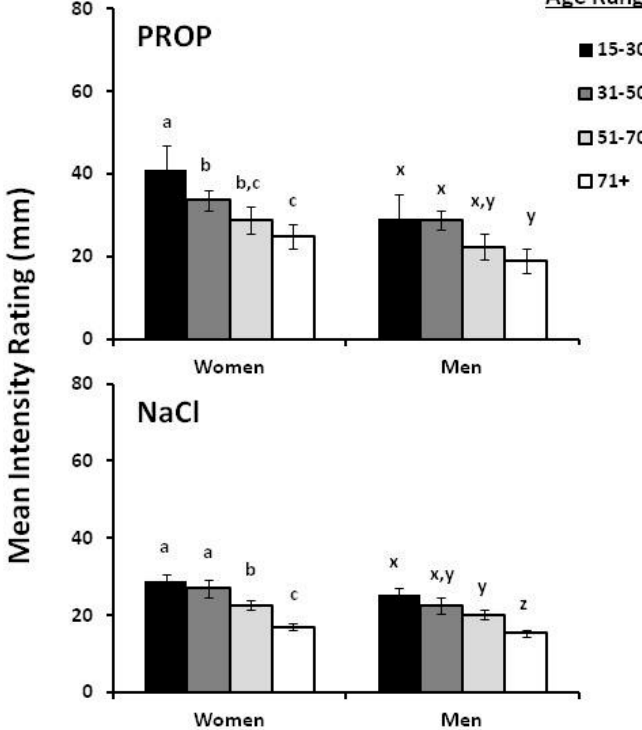
Figure 1. Mean (±Standard Error, SE) 6- n -propylthiouracil (PROP) ( top ) and NaCl ( bottom ) ratings across age groups in both women and men from the isolated community of Val Borbera, Northwest Italy. n = 589; sample size per age group: 59 (15–30 years); 191 (31–50 years); 261 (51–70 years); 78 (71+ years). Ratings by men and women were analyzed separately. For women, mean values within a stimulus type (PROP or NaCl), with different superscripts (a, b and c) are significantly different as a function of age; superscripts x, y and z are used to denote age differences for men. Significant differences, within a stimulus type (PROP or NaCl), are indicated by different letters (a, b and c are used to denote differences for women, while x, y and z for men). For all comparisons, p < 0.001 by Duncan’s Multiple Range test subsequent to ANOVA. Unpublished data from Tepper et al. [107].